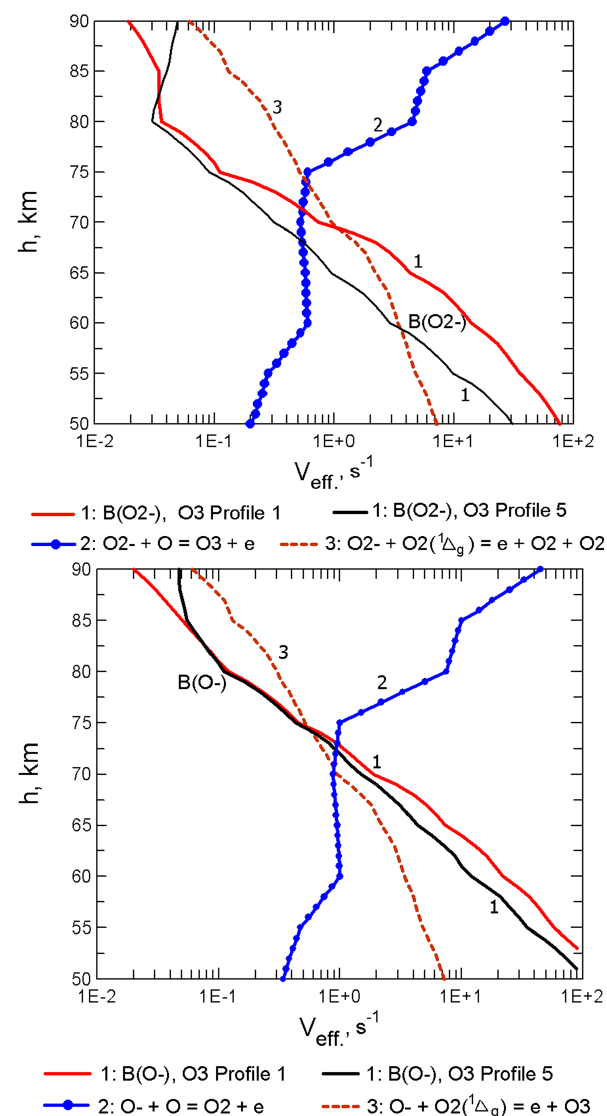
Fig. 5. Upper panel: height profiles of the efficiencies of the re- actions which lead to losses of the O − ion. Lower panel: height 2 profiles of the efficiencies of the reactions which lead to losses of ) and the O − ion. Curves 1 are efficiency of the channels B(O − 2 B(O − ) for the O 3 -profile 1 and 5. Curves 2 and 3 are efficiencies for reactions which do not produce negative